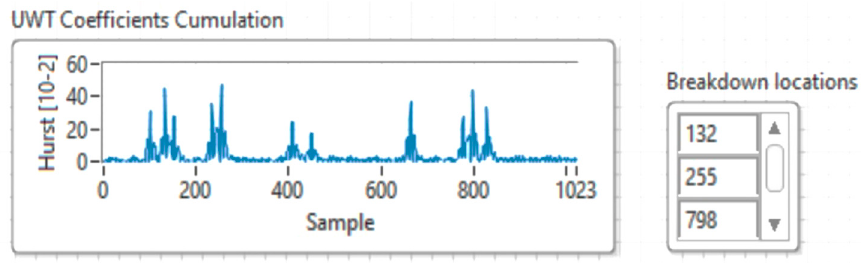
Figure 19. Traffic analysis for intrusion detection using UWT and the Hurst exponent.